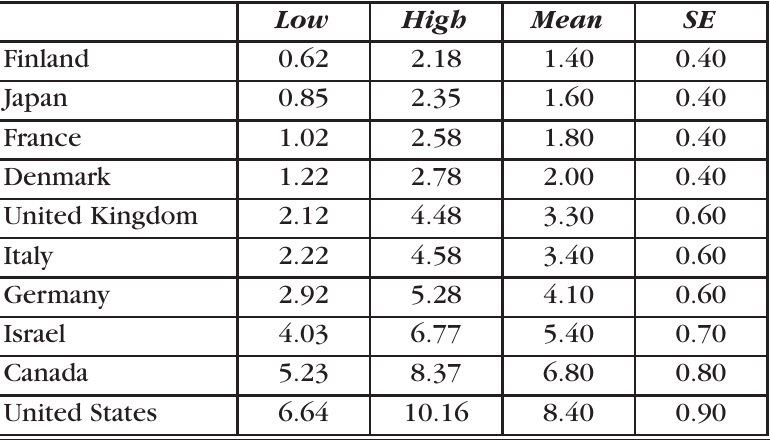
Table 1. Percentage Rates of Entrepreneurial Propensity by Country (95% Confidence